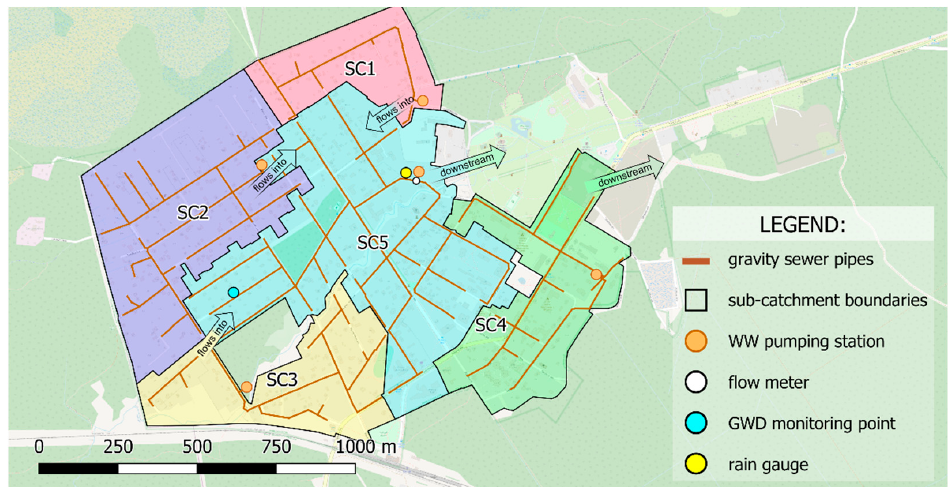
Figure 5. Sub-catchment boundaries and WCS layout in Kemeri. Table 1. Characteristics of the